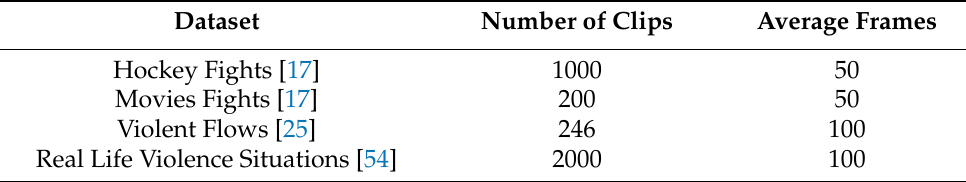
Table 1. Hockey Fights, Movie Fights, Violent Flows and Real Life Violence Situations dataset